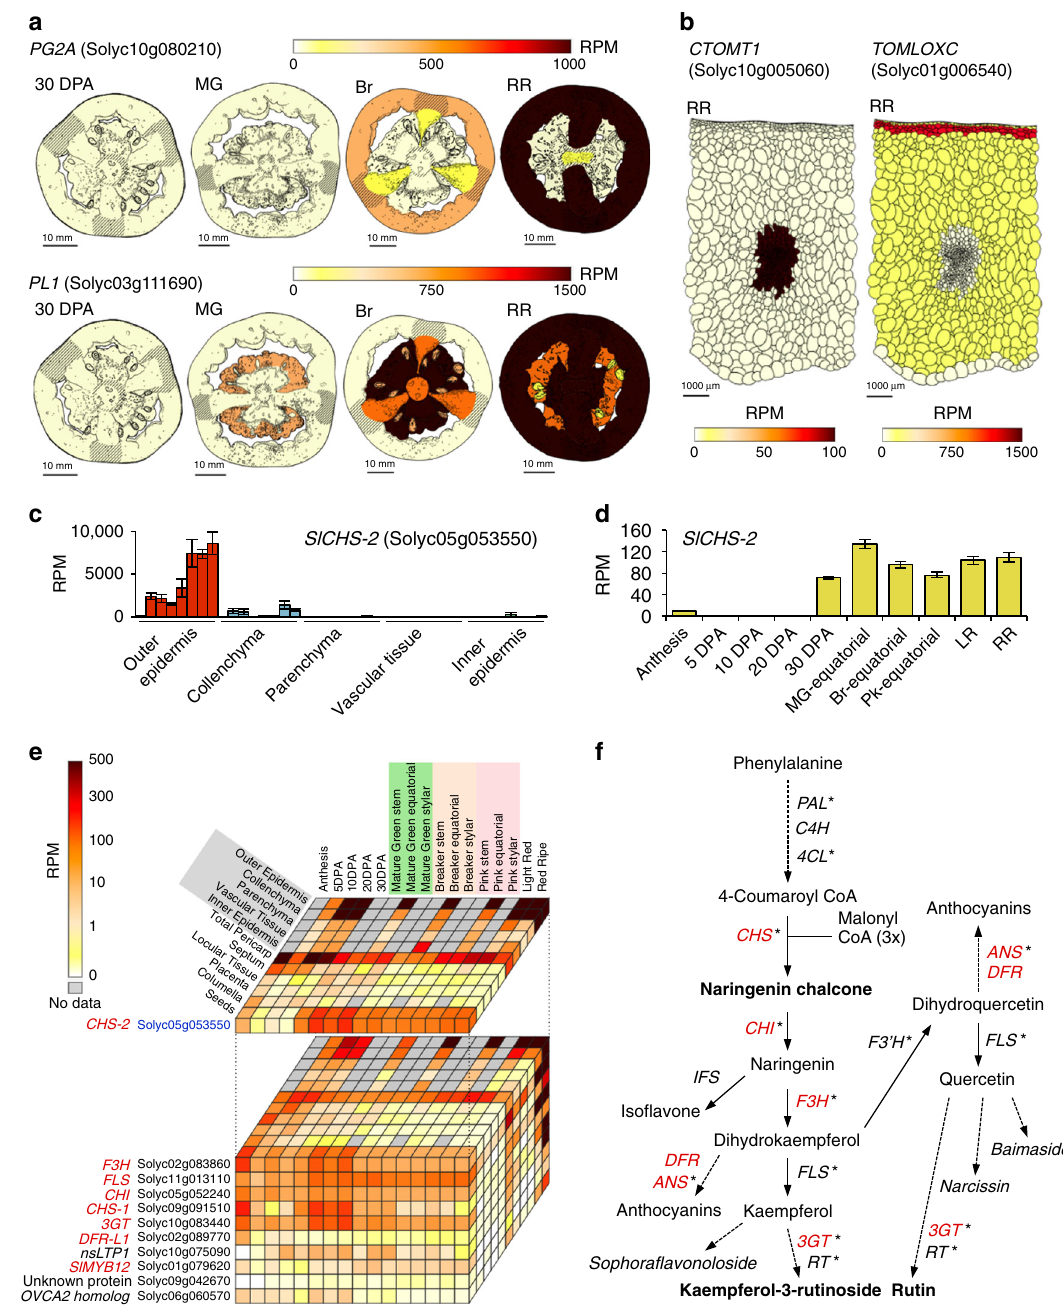
Fig. 2 High-resolution transcript mapping of genes associated with fruit quality traits. a , b Tissue- or cell-based expression images of representative genes associated with fruit softening ( a ) and fl avor ( b ). c , d The expression of SlCHS-2 in the pericarp cell/tissue types ( c ) and seeds ( d ). Colored bars indicate mean RPM ± s.e.m. ( n = 3 in c and 4 in d ) in each cell/tissue type at each stage. Stages in c indicate 5 DPA, 10 DPA, 20 DPA, MG, Br, Pk, LR, and RR from left to right. e Expression cube showing the expression of SlCHS-2 and co-expressed genes. The names of structural and regulatory genes in the fl avonoid biosynthetic pathway are shown in red. f Overview of fl avonoid biosynthetic pathway. Structural genes identi fi ed as co-expressed with SlCHS-2 in c are shown in red. Genes transciptionally activated by SlMYB12 , based on previous studies 27,29 , are indicated by asterisks. Major fl avonoids, mostly fl avonols, found in tomato fruit peel 27 and seeds 28 are shown in bold and italic, respectively. Pictograms in a , b , e were generated through the Tomato Expression Atlas (TEA) database. DPA, days post anthesis; MG, mature green; Br, breaker; PK, pink; LR, light red; RR, red